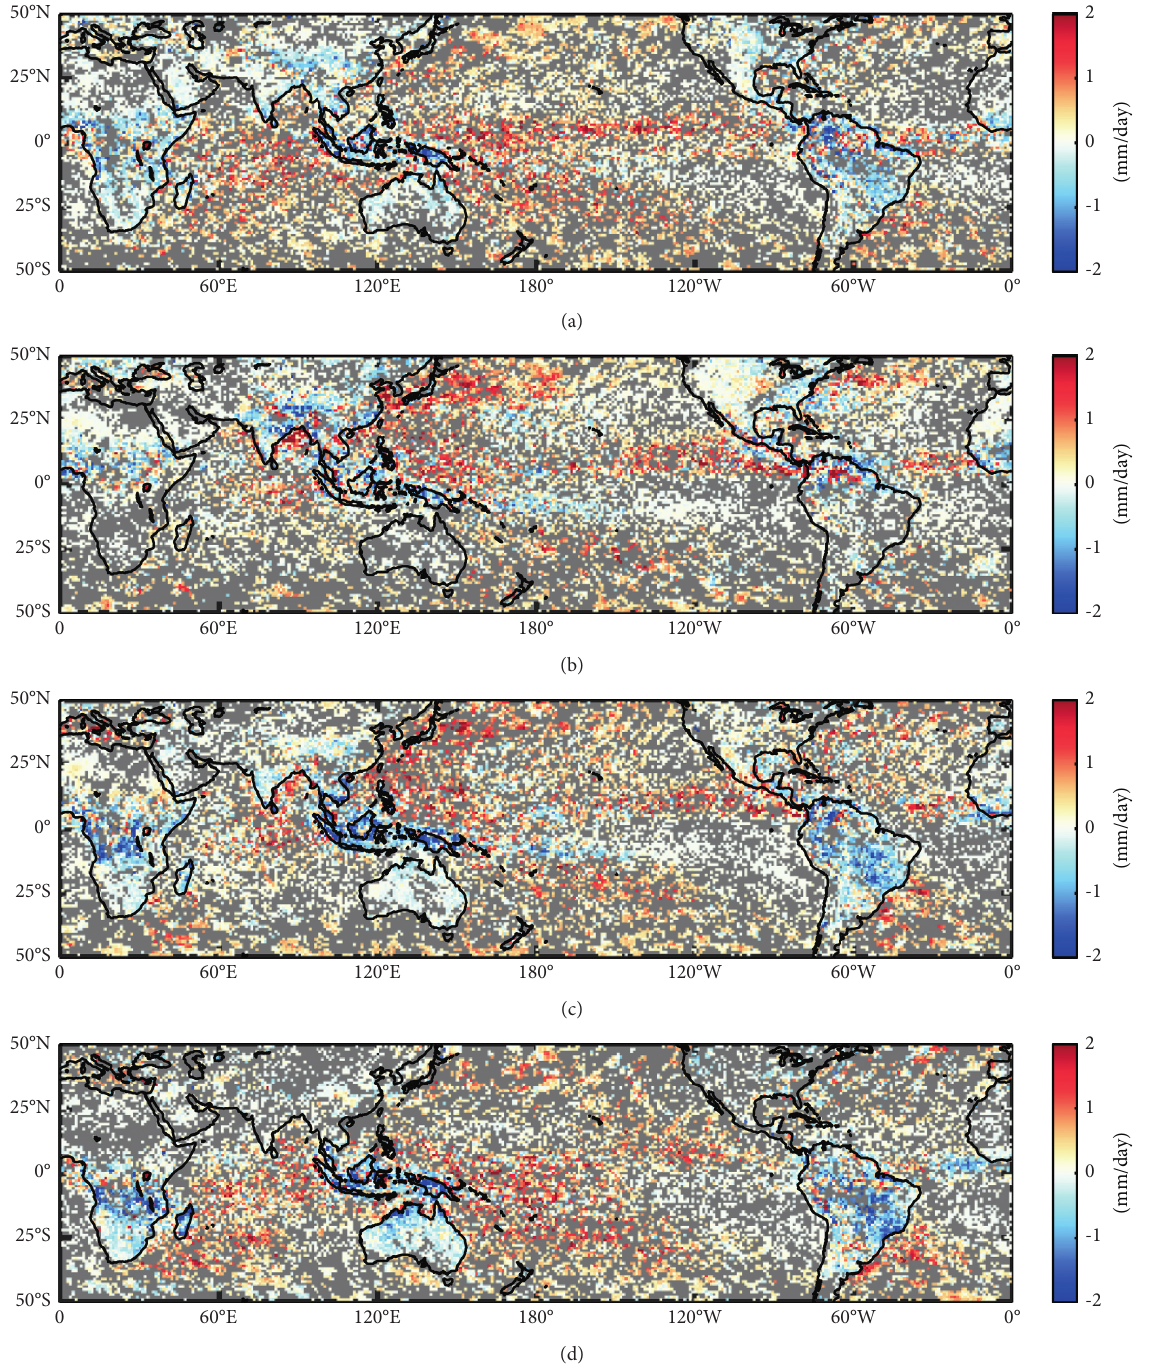
Figure 6: Differences (IMERG V06B minus TMPA 3B42) between the amplitude of the diurnal harmonics in (a) MAM; (b) JJA; (c) SON; and (d) DJF. The grey areas indicate where the diurnal harmonics were not statistically significant at the 90% confidence level in either IMERG or TMPA